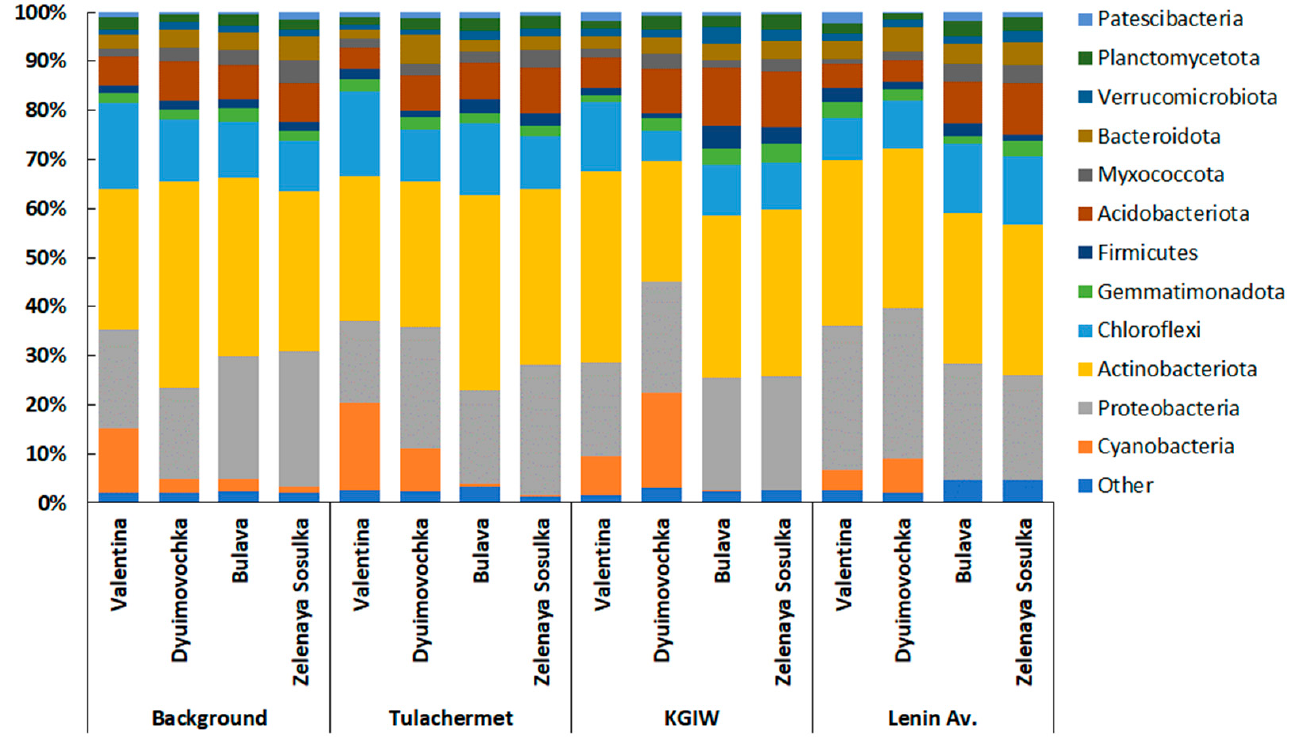
Figure 2. Relative abundances of OTUs associated at the phylum level of the microbial communities in the rhizospheres of four amaranth cultivars grown on different soils.